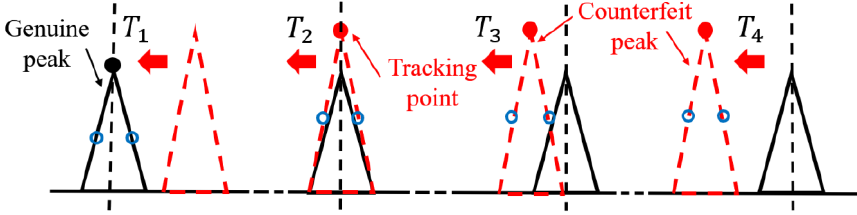
Figure 4. Diagram of asynchronous traction.